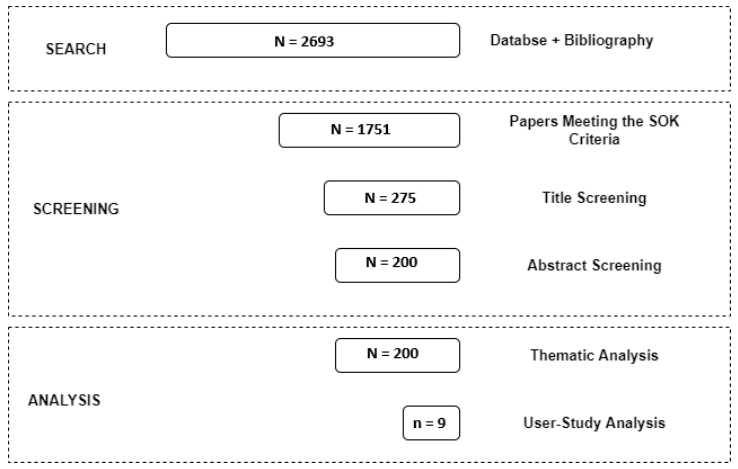
Figure 1. A snapshot of the data collection, screening, and analysis methodology along with the n = # of papers screened in each stage of the literature